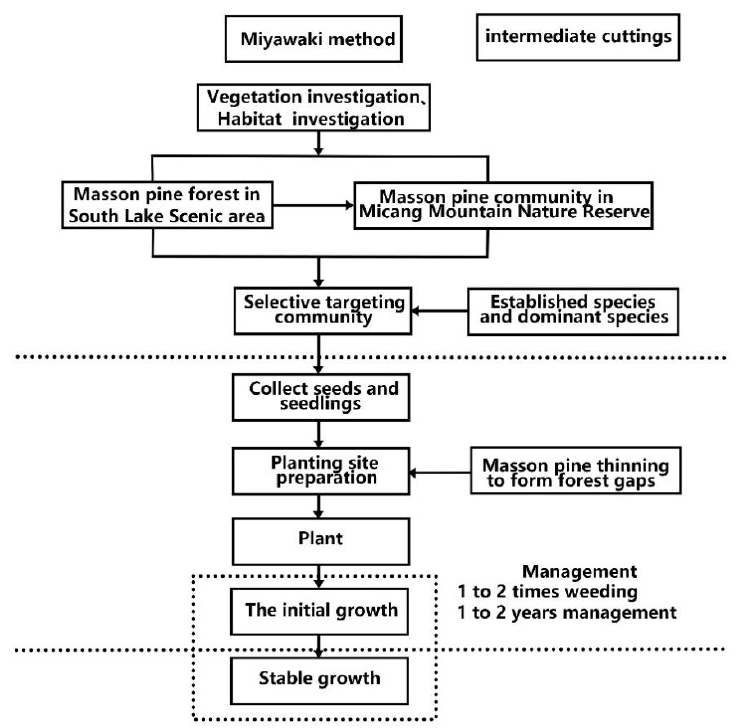
Figure 9. Technical route of Miyawaki afforestation method. Table 6. Table of the main characteristics and the target communities of the site